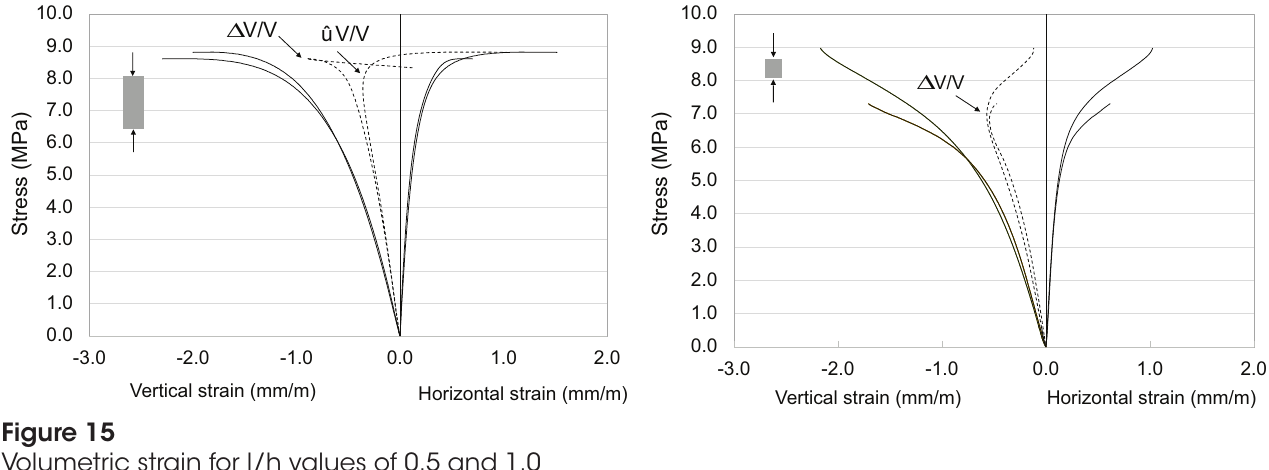
l/h ratio of 1.0 is almost the same for the entire load range. Figure 14 shows the conical cracks that developed in the samples with l/h ratio of 1.0, which relieved the strain at the surface of the samples and caused the samples to fail. Cracks were not observed until a vertical strain level of approximately 2.0 mm/m. Shah and Chandra [29] presented a formula to determine the volu- metric strain modification using the vertical (ε ) and horizontal (ε ) v h strain differences, as shown in Equation 1. (1) Where ΔV is the change in volume, and V is the original volume. Figure 15 shows the volumetric strains for all samples tested in this phase of the research, as computed according to Equation 1. For both l/h ratios, the volumetric strain changes near failure, as shown by the dotted line in Figure 15. At the beginning of the test, there is a continu- ing decrease in the volume strain (ΔV/ V ) for both l/h ratios. Near fail- ure, however, the samples experienced expansion, due to cracking.